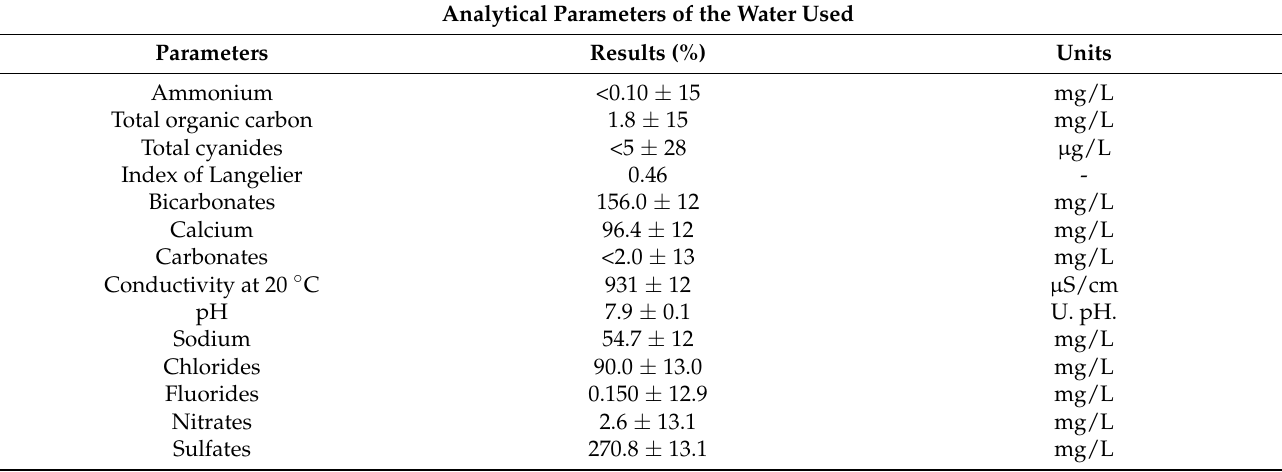
Table 1. Analytical parameters of the water used in the preparation of the mortars (Aquagest Levante, S.A.) Analytical Parameters of the Water Used Parameters Results (%)